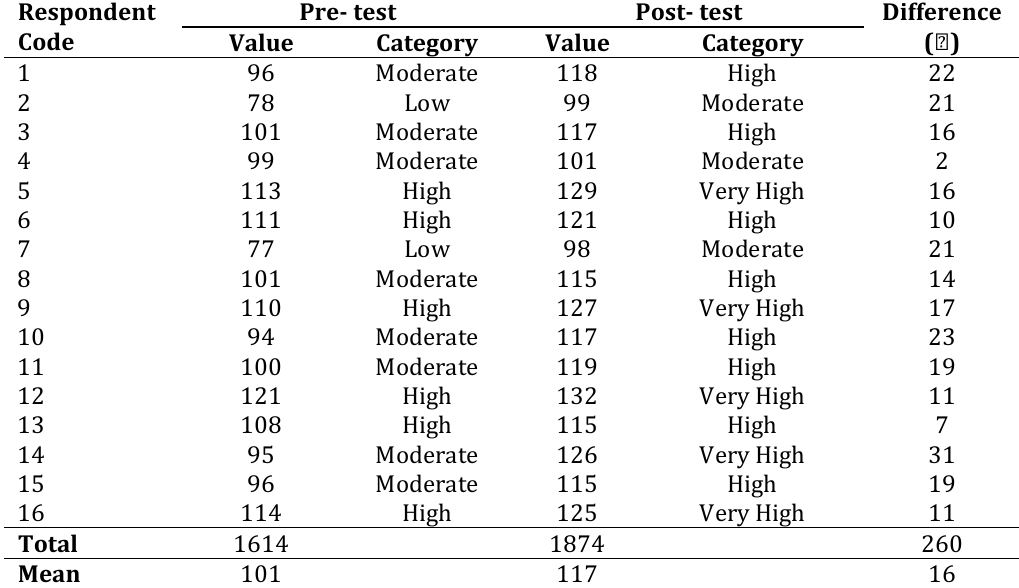
Table 2 Differences in Quality of Life in the Treatment Group